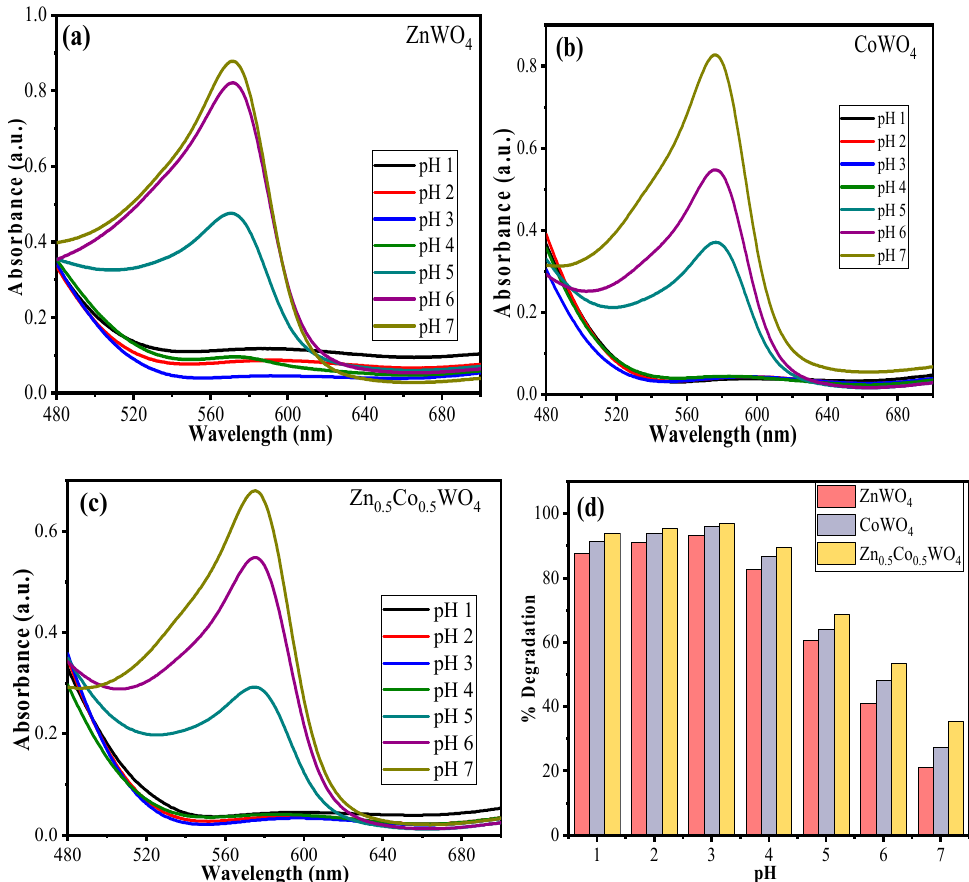
Figure 9. Effect of solution pH on photocatalytic degradation by ( a ) ZnWO 4 ; ( b ) CoWO 4 ; ( c ) Zn 0.5 Co 0.5 WO 4 ; ( d ) XO degradation (%) vs. pH bar graph. Table 2. The kinetic parameters for the degradation of XO dye (20ppm) using 10 mg ZnWO 4 , CoWO 4, and Zn 0.5 Co 0.5 WO 4 with variable irradiation time (5–120 min). Material k 1 (min − 1